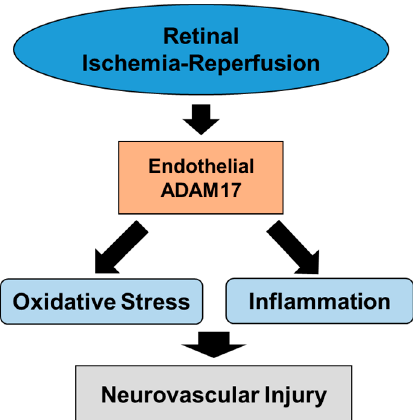
Figure 9. Diagram summarizing the role of endothelial ADAM17 in IR-induced retinal neurovascular damage.